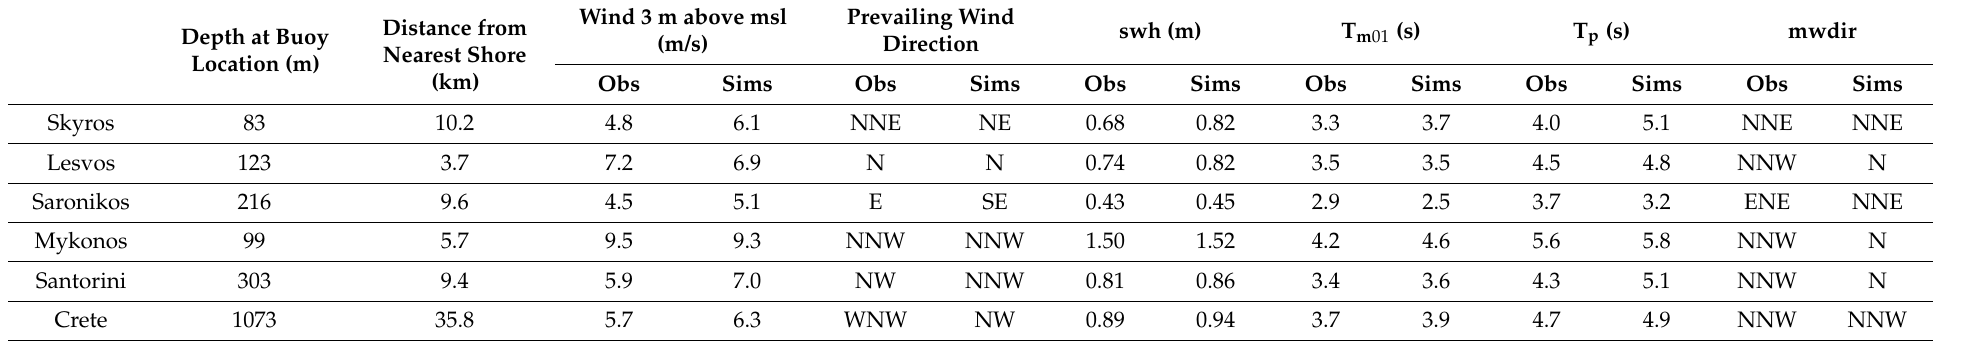
Table 2. Mean observed and simulated values for atmospheric and wave variables from 4 to 7 September 2011 at buoy locations. Depth at